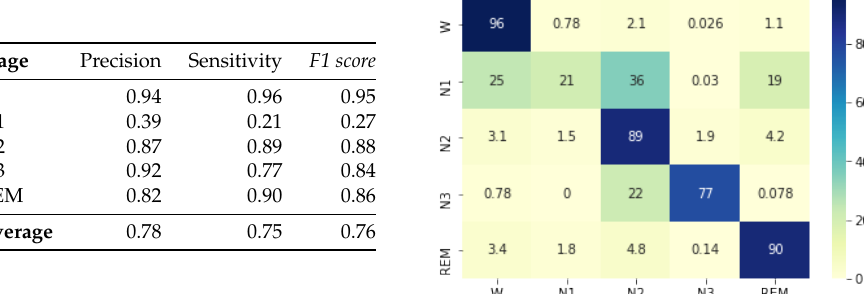
Figure 2. Confusion matrix for the test set classification using the 5 model